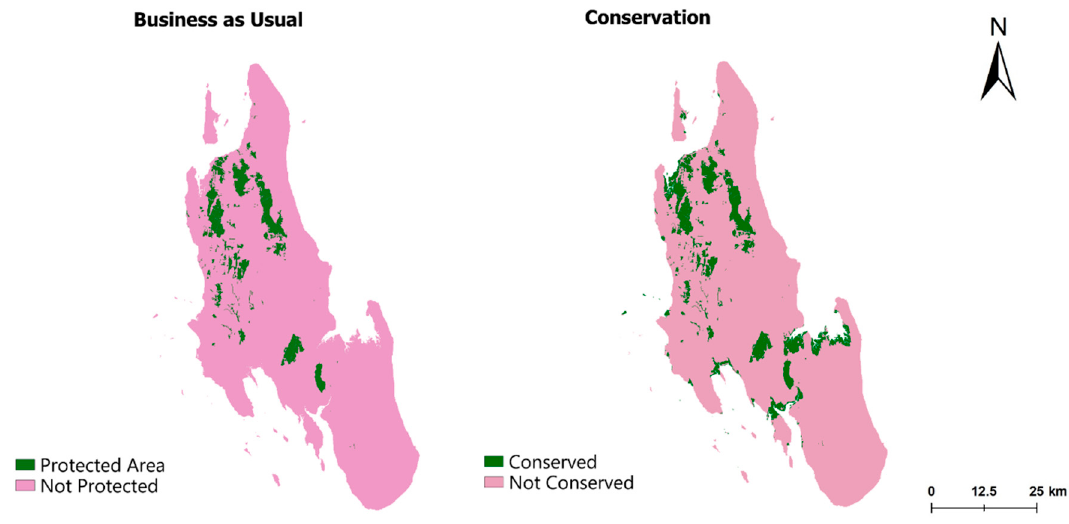
Figure 3. Business as usual ( left ) and conservation scenarios constraints ( right ).